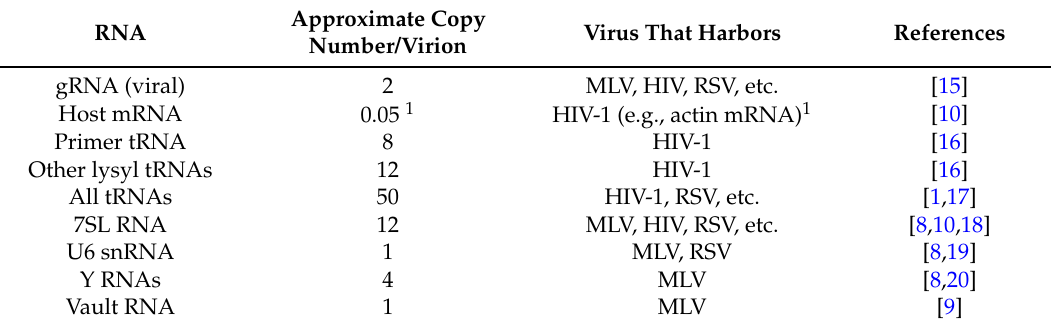
Table 1. Some of the RNAs in retroviral